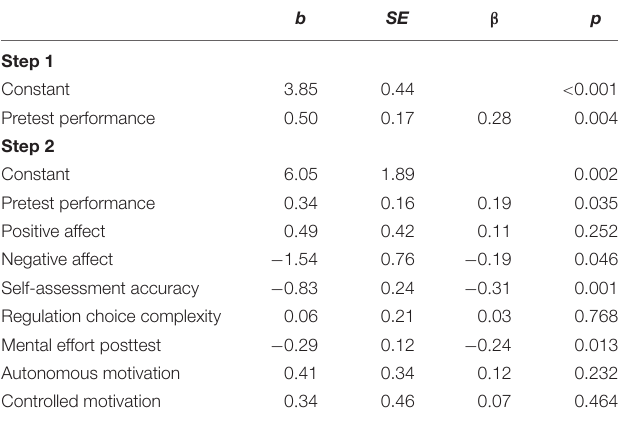
TABLE 3 | Stepwise regression with predictors of problem-solving